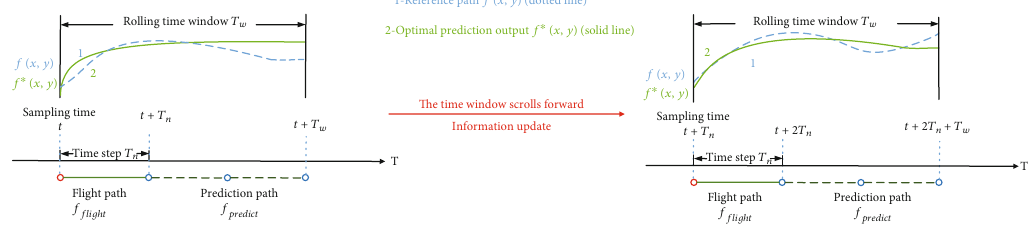
Figure 2: Path planning diagram of receding horizon control.